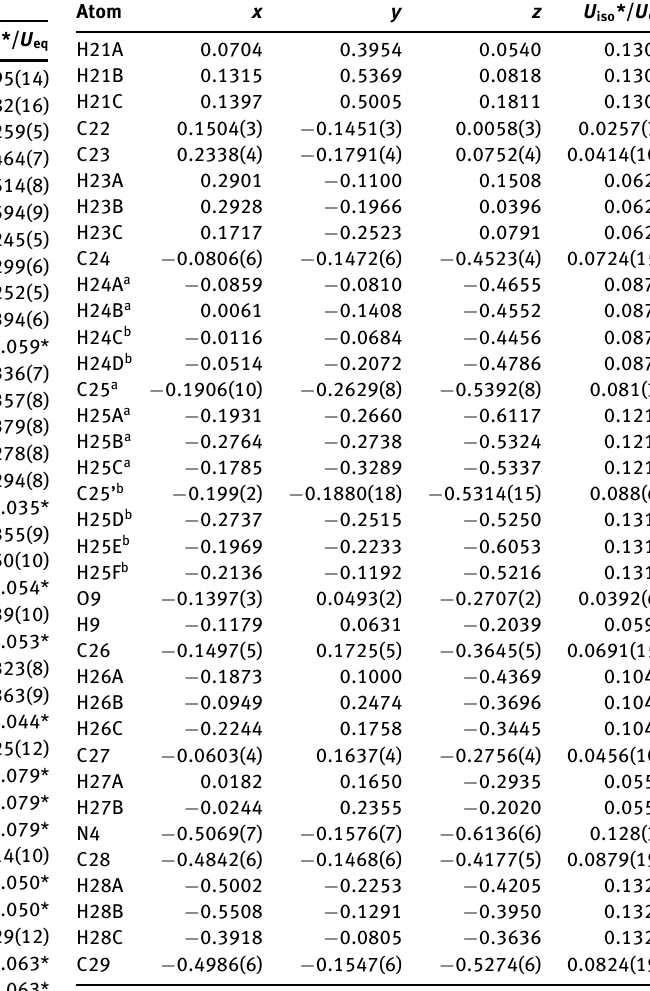
Table 2: Fractional atomic coordinates and isotropic or equivalent isotropic displacement parameters (Å 2